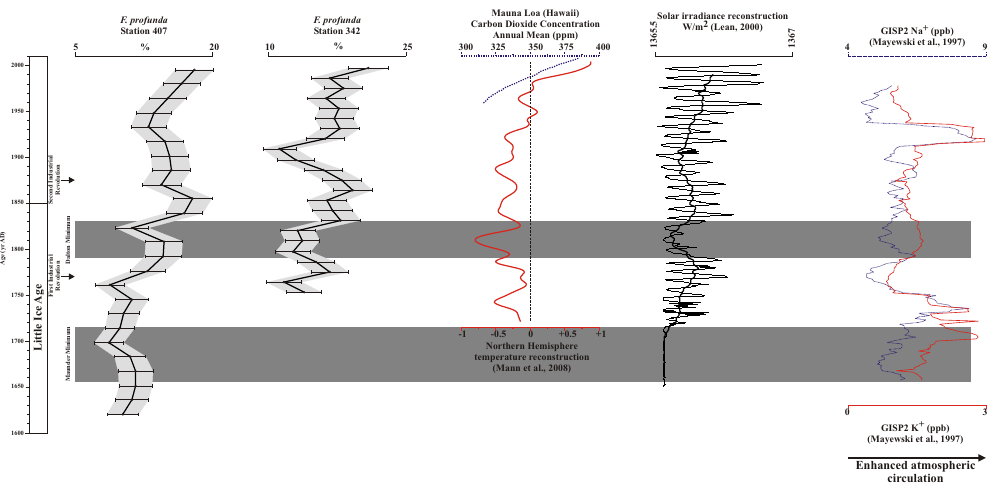
Fig. 7. Downcore variations of F. profunda percentage values (counted against 1000 other coccoliths); the gray shadow indicates the error for a 95% confidence level at St 407 and 342, plotted together with climatic proxy records: carbon dioxide at Mauna Loa (Hawaii, annual mean in ppm) from 1959 AD (http://www.ncdc.noaa.gov/paleo/paleo.html); Northern Hemisphere temperature reconstruction (Mann et al., 2008); Solar irradiance reconstruction (W/m 2 ) since the Maunder Minimum (Lean, 2000); GISP 2 ice core sea salt Na and non-sea-salt K records, expressed in ppb (Mayewski et al., 1997).